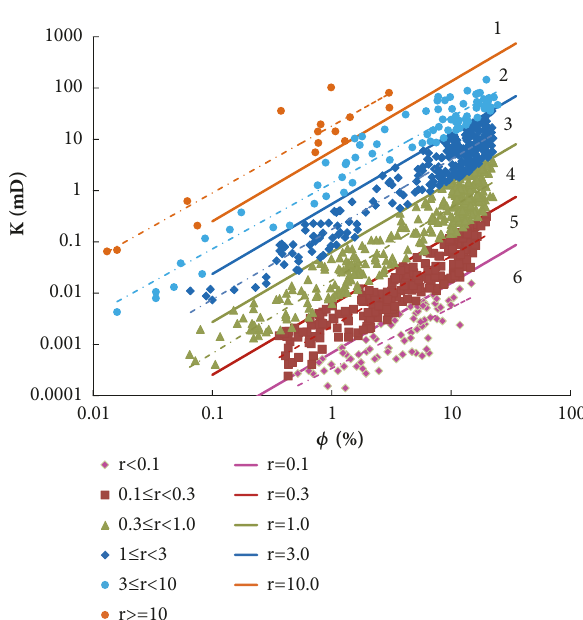
Figure 1: Correlation coefficients of fitting equations of porosity, permeability, and pore throat radii under different mercury injec- tion saturations.